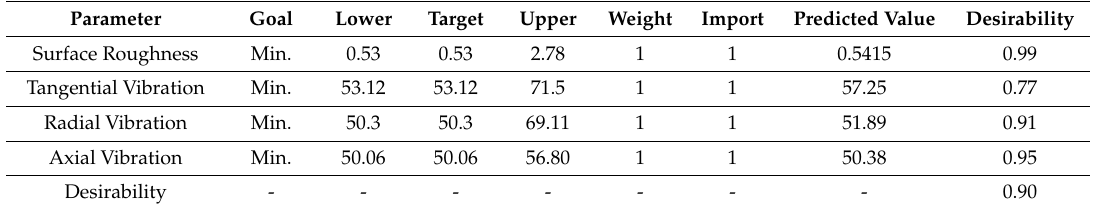
Table 7. Response surface methodology parameter design and predicted responses.